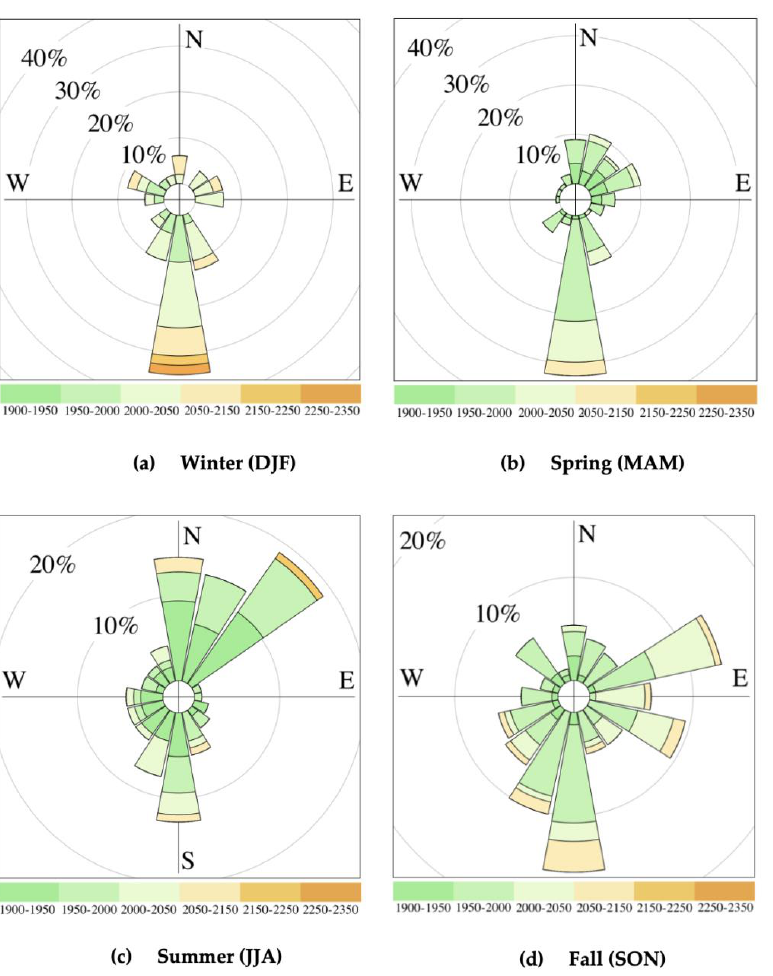
Figure 12. Angular distribution of atmospheric CH 4 concentrations throughout the period of ob- servations (September 2018 – February 2020): frequency of counts (%) and dry mole fractions (ppb). Afternoon data records for CH 4 and corresponding wind directions (1 – 4 pm LT) are shown.